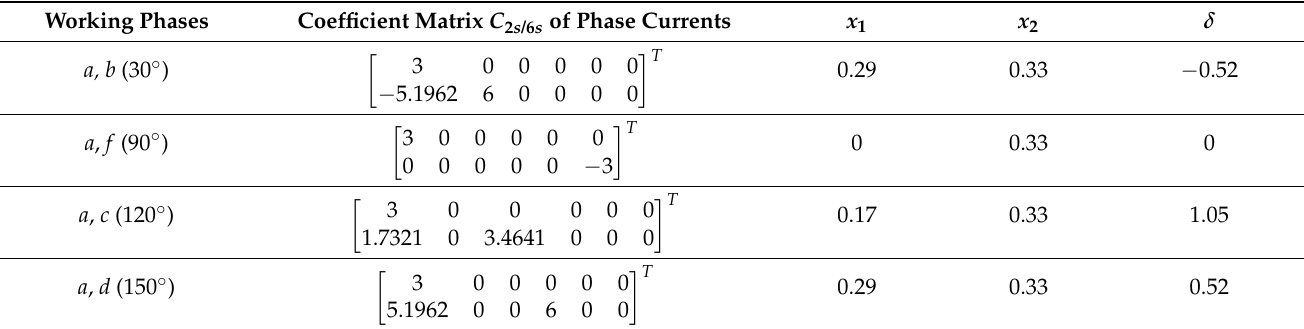
Table 7. Optimum Solutions of Phase Currents and Parameters of Matrix X Under Four-Phase-Open Fault with Neutral Point